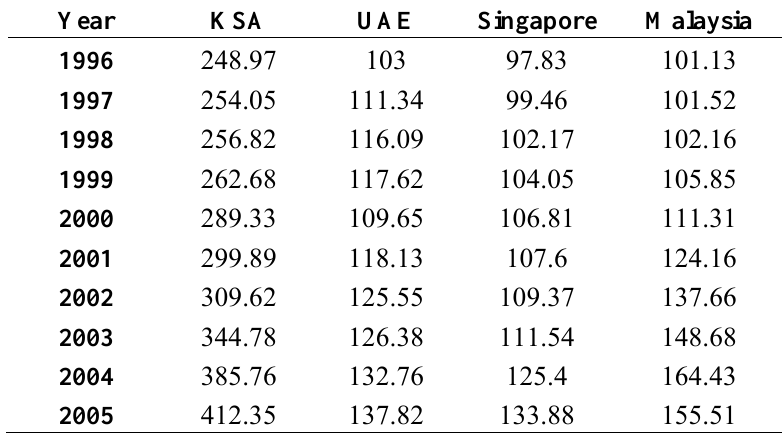
Table 5. Comparison of total emission (CO2 Million Metric tons).